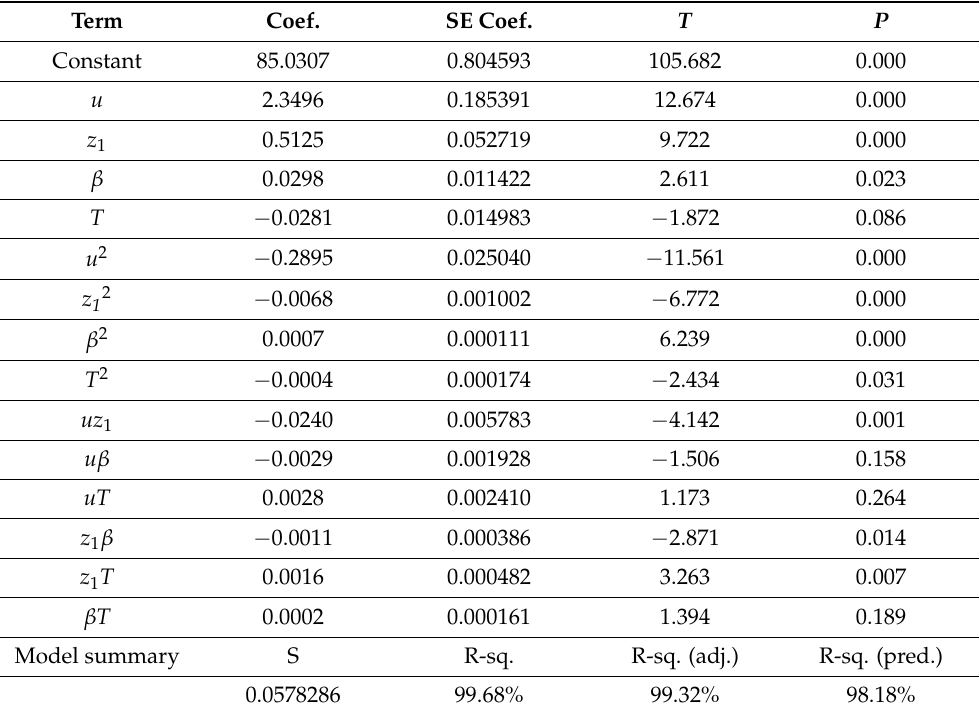
Table 4. Regression analysis results based on Box–Behnken design